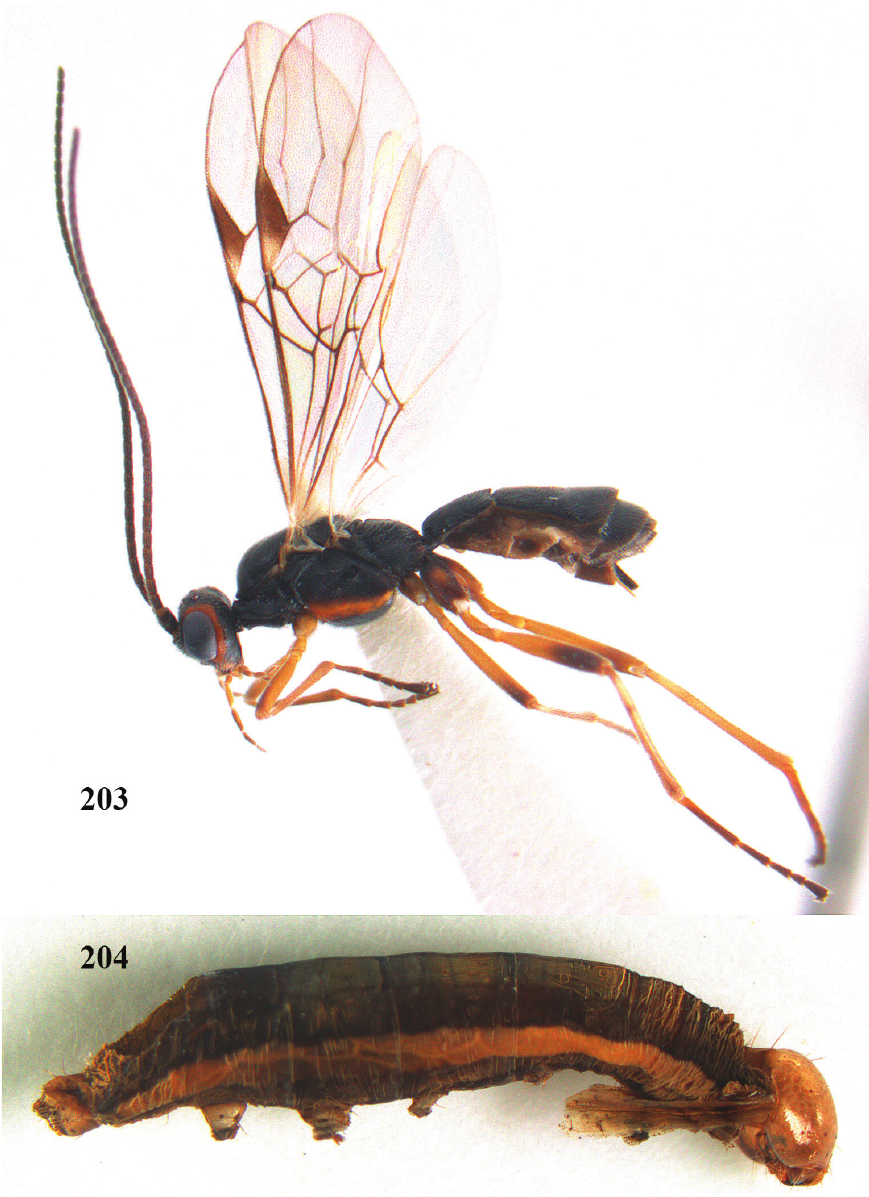
Figures 203–204. Aleiodes leptofemur sp. n., ♀ , holotype. 203 habitus lateral 204 mummy of Stilbia anomala